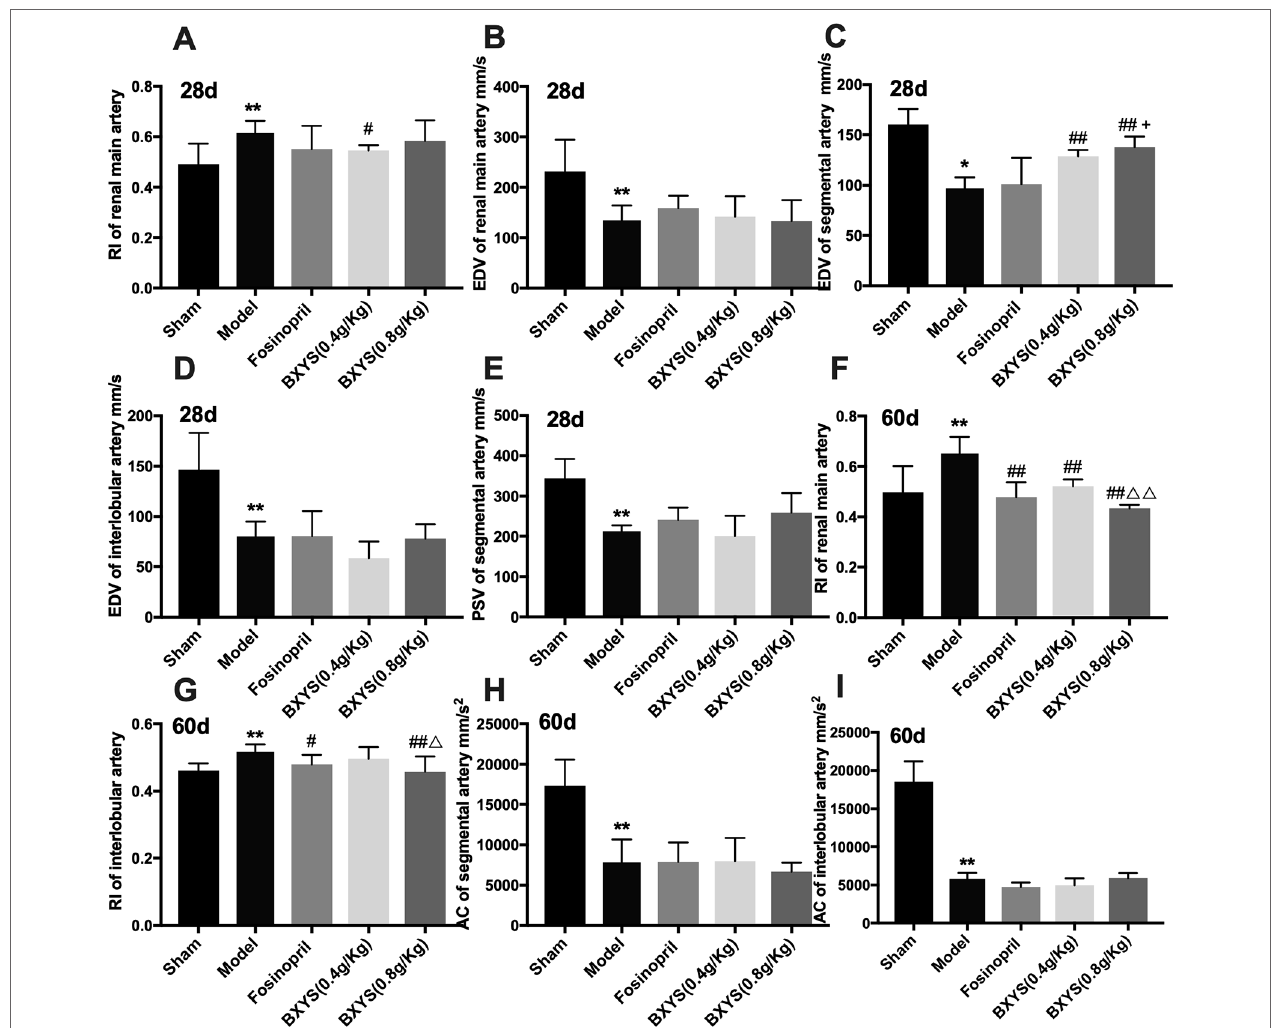
FIGURE 2 | Renal hemodynamics after 28 days and 60 days of drug administration. Sham, sham group; Model, model group; Fosinopril, fosinopril group; BXYS (0.4g/kg), Buxin Yishen 0.4g/kg treated group; BXYS (0.8g/kg), Buxin Yishen 0.8g/kg treated group. *P < 0.05, **P < 0.01 vs. sham group. # P < 0.05, ## P < 0.01 vs. model group. + P < 0.05 vs. fosinopril group. Δ P < 0.05, ΔΔ P < 0.01 vs. BXYS (0.4g/kg) group. (A) Renal main artery resistance index (RI) after 28 days. (B) Renal main artery end diastolic velocity (EDV) after 28 days. (C) Segmental artery EDV after 28 days. (D) Interlobular artery EDV after 28 days. (E) Segmental artery peak systolic velocity (PSV) after 28 days. (F) Renal main artery RI after 60 days. (G) Interlobular artery RI after 60 days. ( H) Segmental artery acceleration (AC) after 60 days. (I) Interlobular artery AC after 60